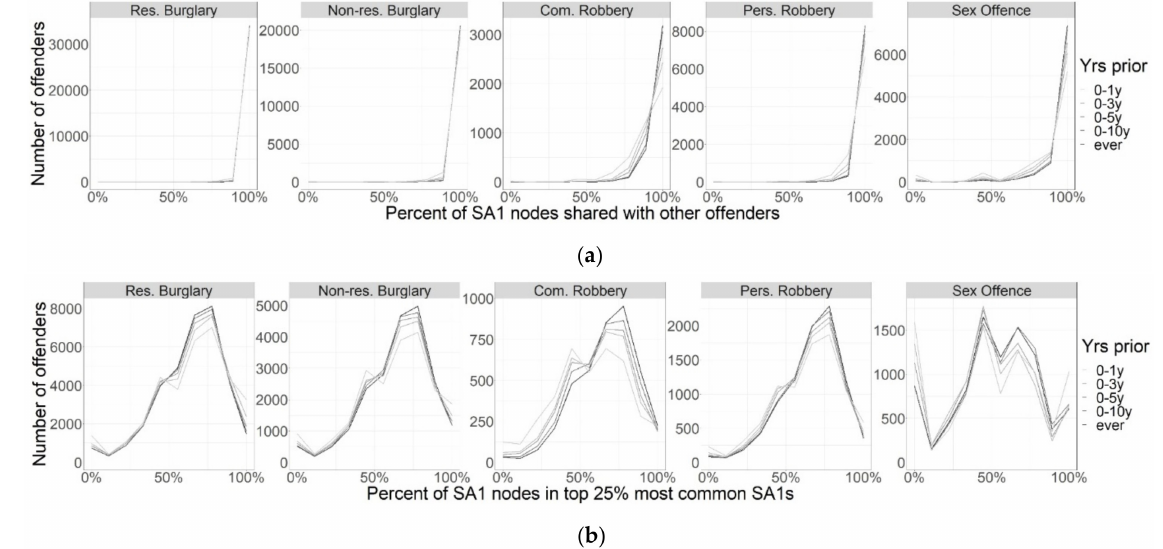
Figure 4. Distribution of proportion of activity space shared with any other offenders ( a ) and in the top 25% most commonly shared SA1s ( b ), by reference offense type and timeframe preceding the reference